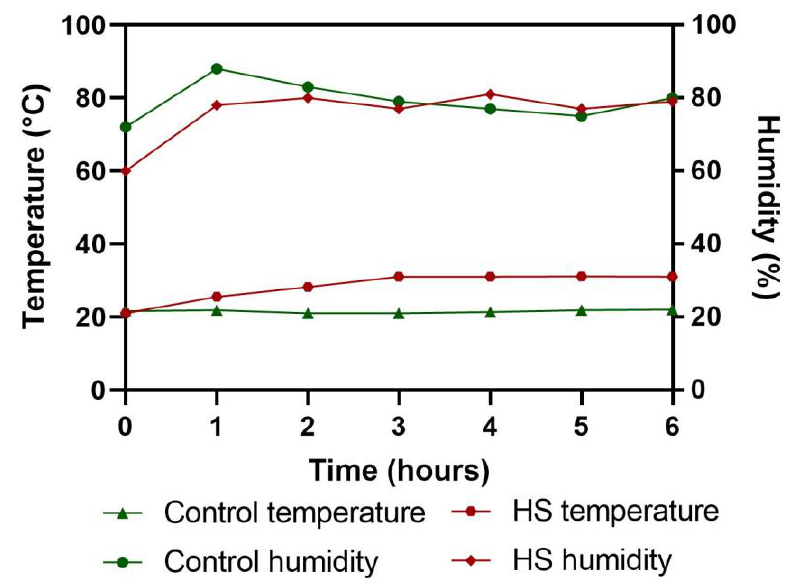
Figure 1. Changes in the temperature (°C) and relative humidity (%) of the rooms over the entire period of the experiment.